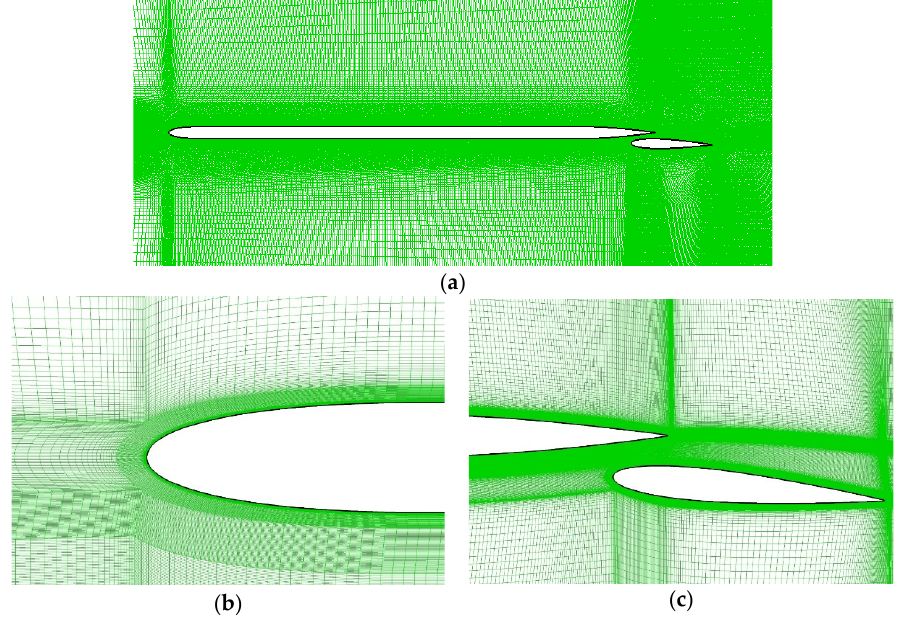
Figure 3. Structural meshes of wing and flap configuration: ( a ) the whole view; ( b ) zoom-in view near the leading edge; ( c ) zoom-in view near the flap.